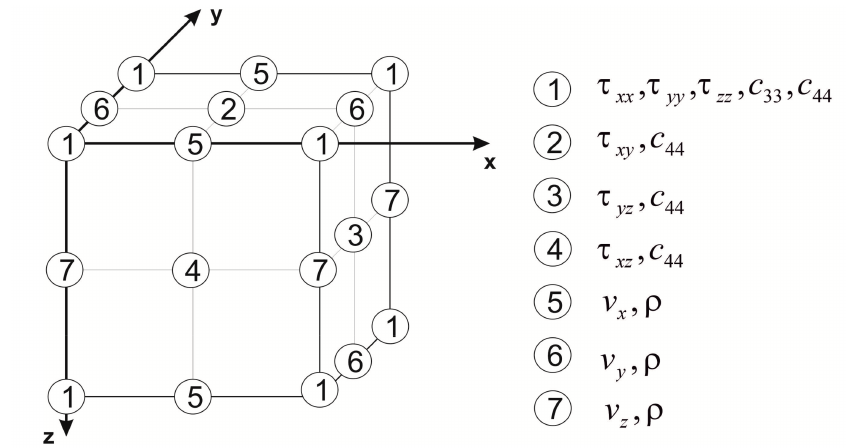
Figure 1. The layout of a finite di ff erence grid cell for the staggered grid formulation in anisotropic media. The node numbers define the locations of stress components, elastic parameters and density.